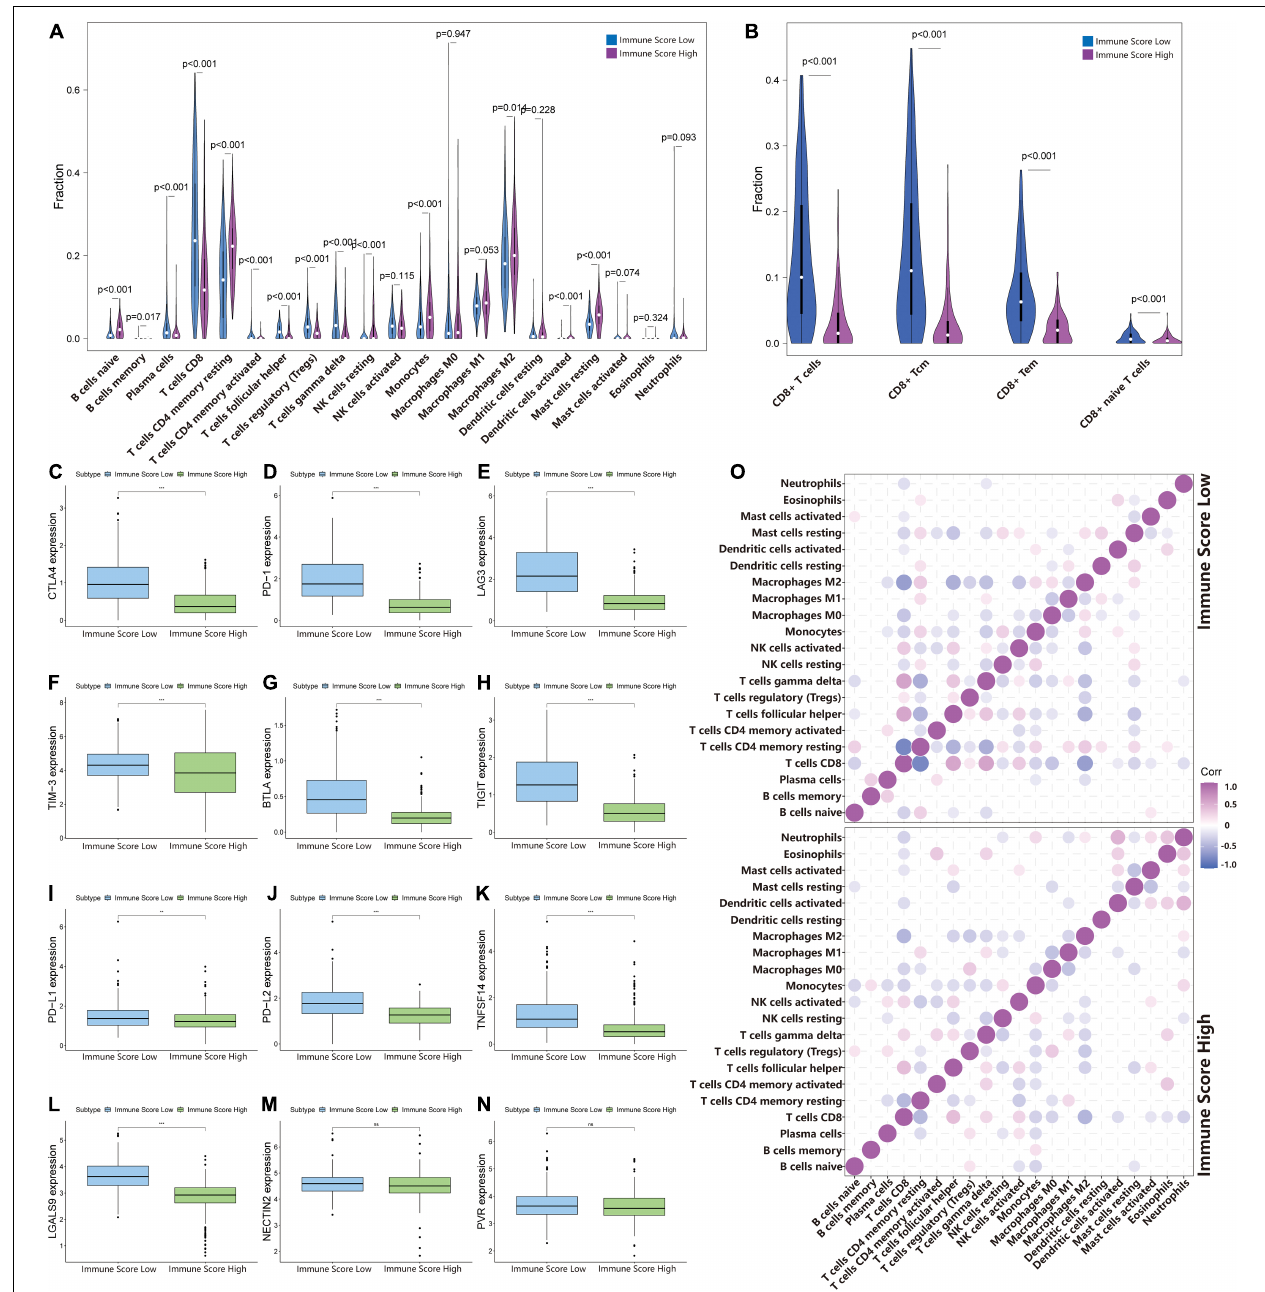
FIGURE 5 | Changes in immune cell infiltration in different immune score groups. (A,B) The horizontal axis and vertical axis represent tumor infiltrating immune cells and relative percentages, respectively. Blue and purple represent the ISL group and ISH group, respectively. The data were evaluated using Wilcox tests. (C–N) The expression of inhibitory receptors and inhibitory ligands of CD8 + T cells between the ISL group and ISH group. The upper and lower ends of the box indicate the interquartile range of values. The line in the box indicates the median value, and the black dot indicates the outlier. Asterisks indicate statistical p -values (** < 0.01, *** < 0.001). (O) The relationship between the abundance ratios of different tumor immune infiltrating cells. The dot indicates that the p -value is less than 0.05, and the area is negatively correlated with the p -value. Purple indicates a positive correlation, and blue indicates a negative